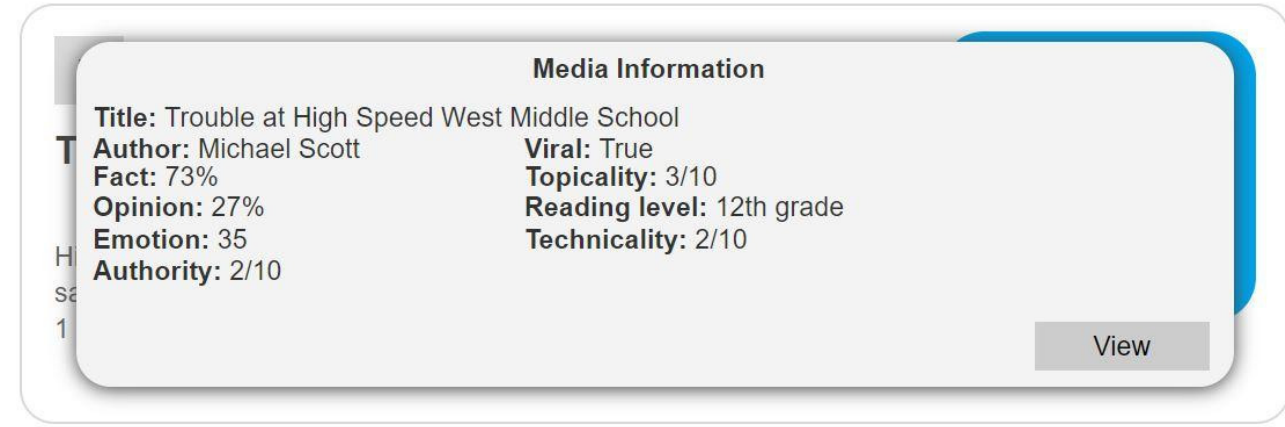
Figure 4. Informational label without article summary [76].